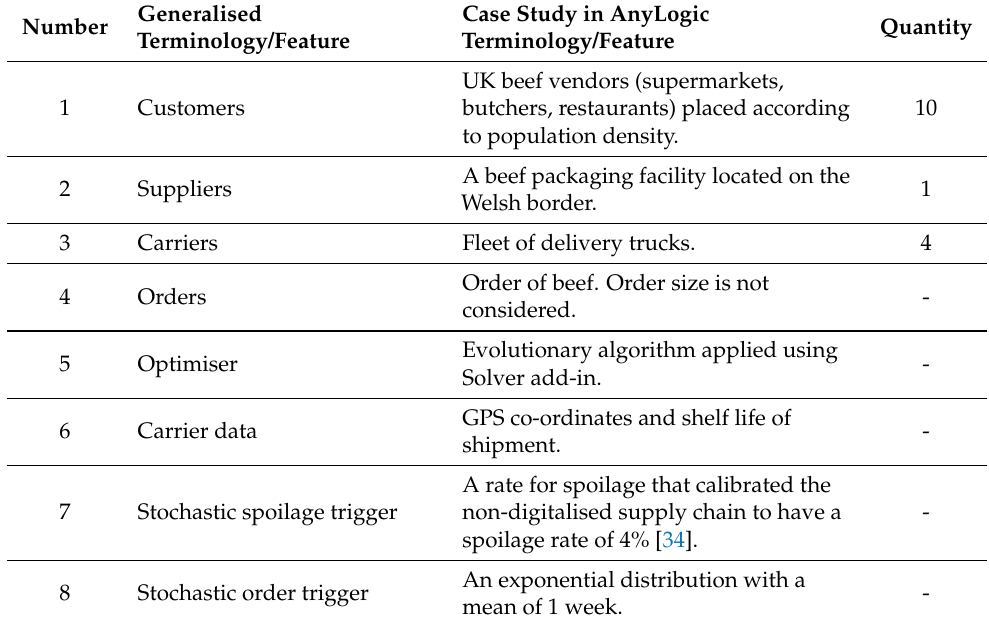
Table 3. Conversion of the general modelling terminology/description into an AnyLogic specific format.